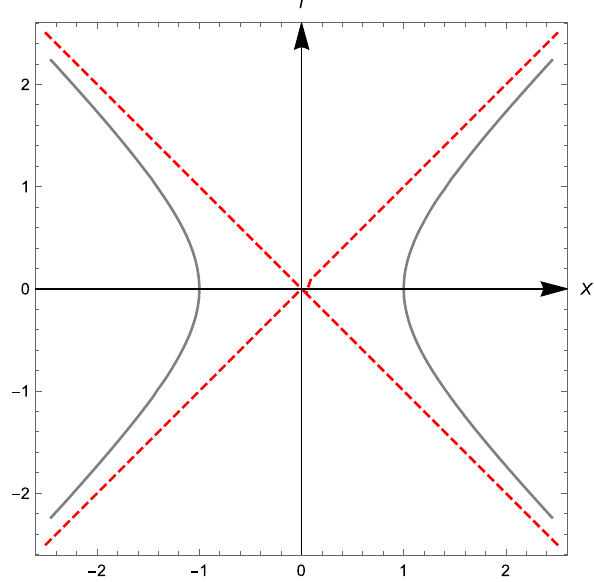
Fig. 1 Worldlines of Rindler observers on the right and left wedges, shown in gray (solid) lines. The Rindler horizons separating the wedges are shown as the red (dashed)